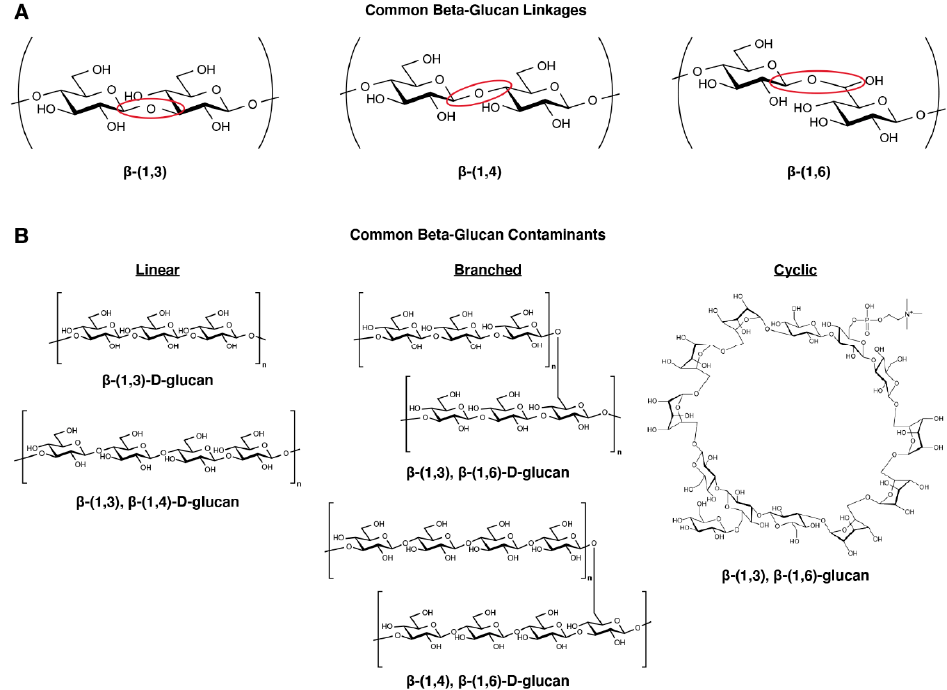
Figure 2. Chemical structures of beta-glucans. ( A ). Beta-glucans are named according to the positioning of the glycosidic linkage. The nomenclature specifies which carbons of the glucose rings are conjugated to form the polymeric structure, with carbon 1 always representing the anomeric carbon. For example, a β -(1,3) linkage conjugates the anomeric carbon of one glucose moiety to carbon 3 of another glucose moiety. β -(1,2), β -(1,3), β -(1,4), and β -(1,6) are all common linkages for